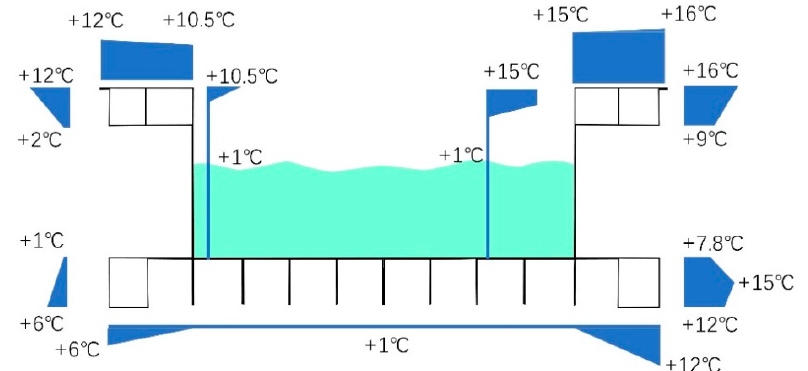
Figure 20. Simplified temperature gradient under the full-water condition in winter.